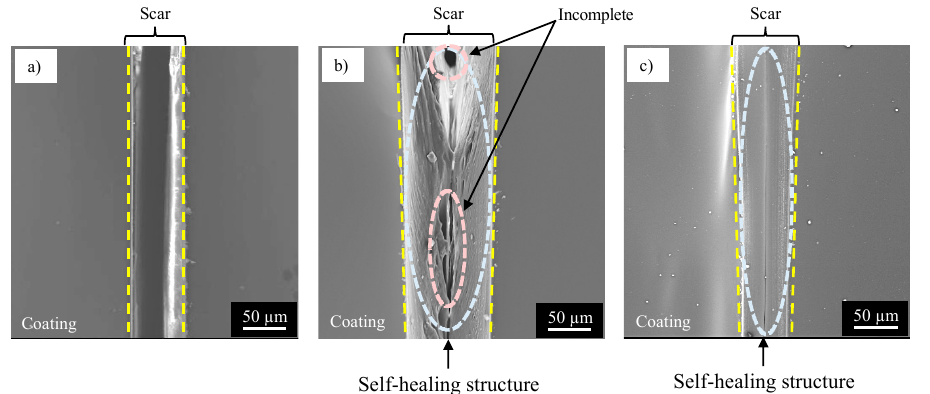
Figure 8. SEM images of the damaged specimen surface covered with a coating ( a ) with no capsule (NC), ( b ) with spherical capsules (SHC-SC), and ( c ) with spherical and fibrous capsules (SHC-SFC).